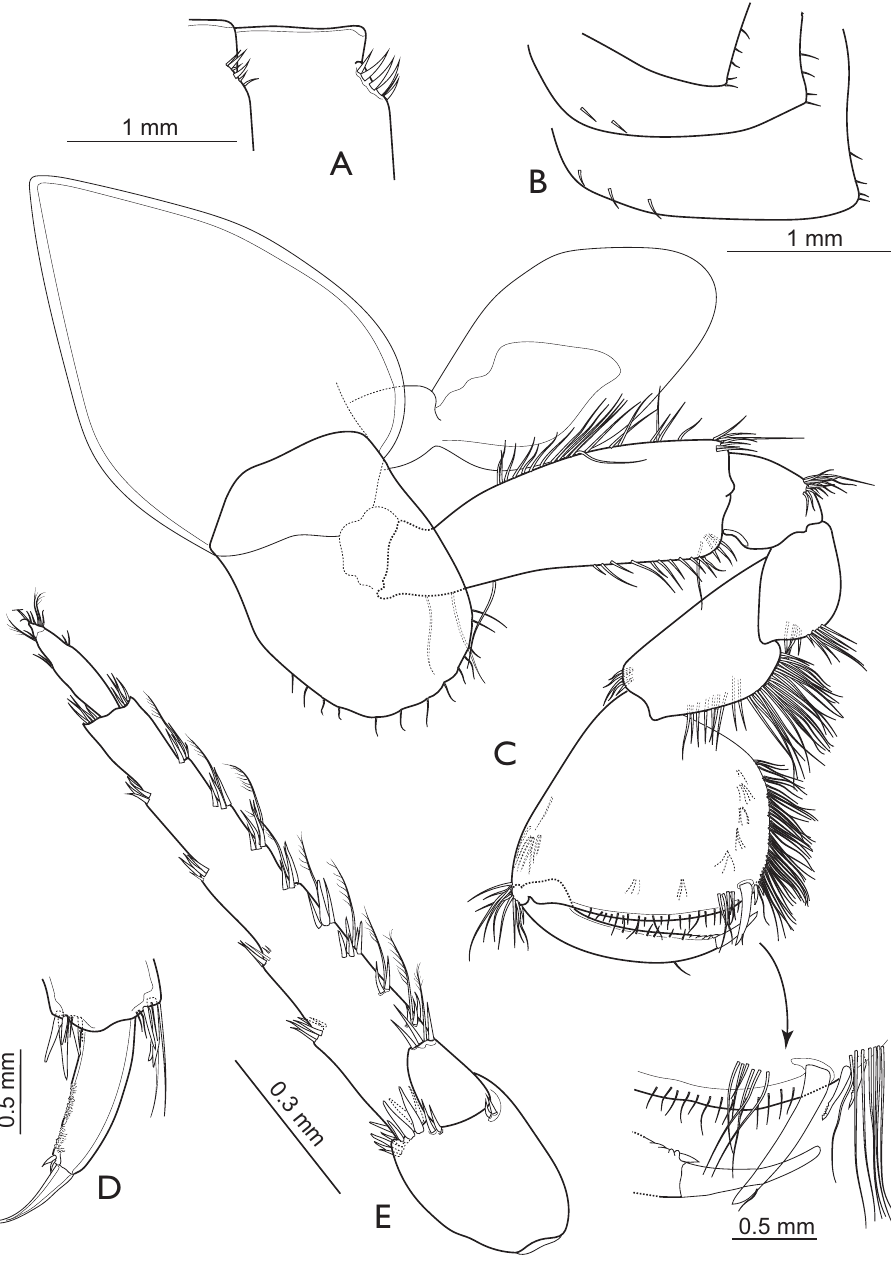
Figure 13. Niphargus enslini , topotype female from the Falkensteiner Höhle (BZM 24795) A pleonites 2–3, dorsal margin with spines B epimeral plates 1–3 (left side) C gnathopod II with gill and oostegite (enlarged: the palmar corner), outer side D dactylopodite of pereopod 7 E uropod III